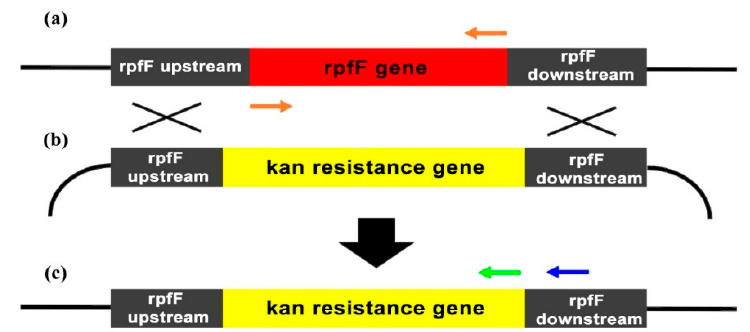
Figure 1. Schematic representation of the mutagenesis cassette cloned in the donor plasmid prpfF-kan for homologous recombination and replacement of the target rpfF gene with the kanamycin resistance gene ( kan ) in the genome of X. fastidiosa strain De Donno. ( a ) rpfF gene structure on the X. fastidiosa gene region, indicating the two ( rpfF upstream and rpfF downstream) amplified regions of the gene; ( b ) structure of the prpfF-kan donor plasmid structure; and ( c ) structure of the X. fastidiosa genome after homologous recombination. PCR primers RpfF_F/RpfF_R, Kan_F/Kan_R, RpfFMut_F/RpfFMut_R, used to verify the effectiveness of recombination, are indicated by orange, green, and blue arrows, respectively.